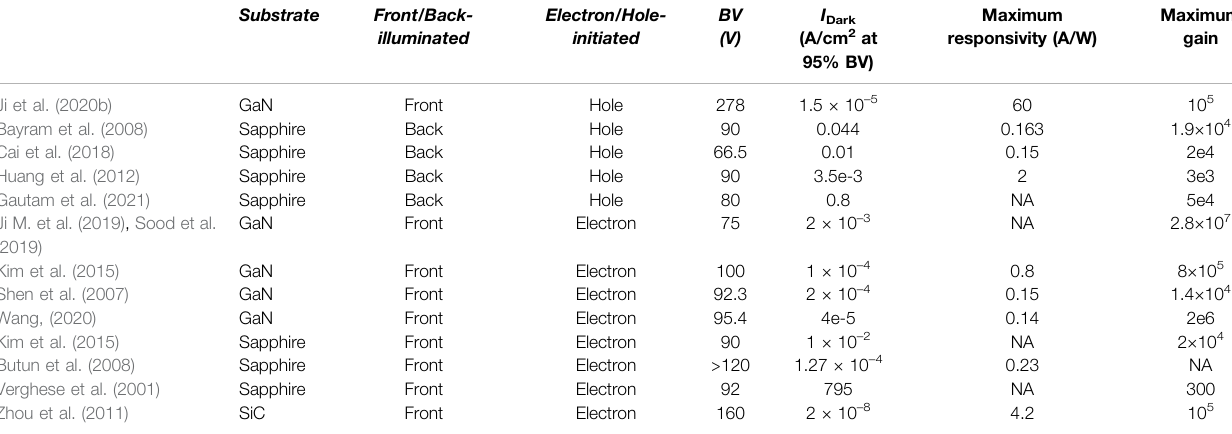
TABLE 5 | Summary of the reported key results on GaN avalanche